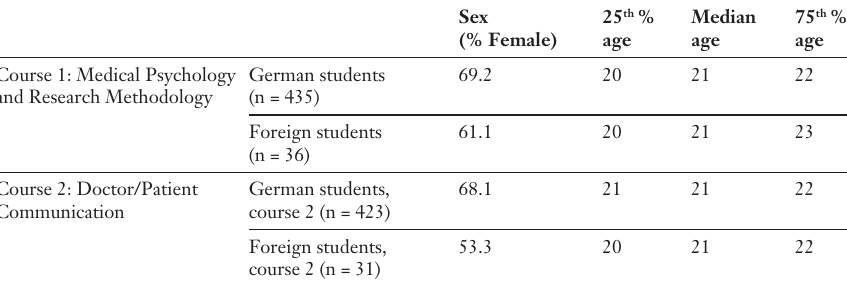
Table 1. Sex and age of